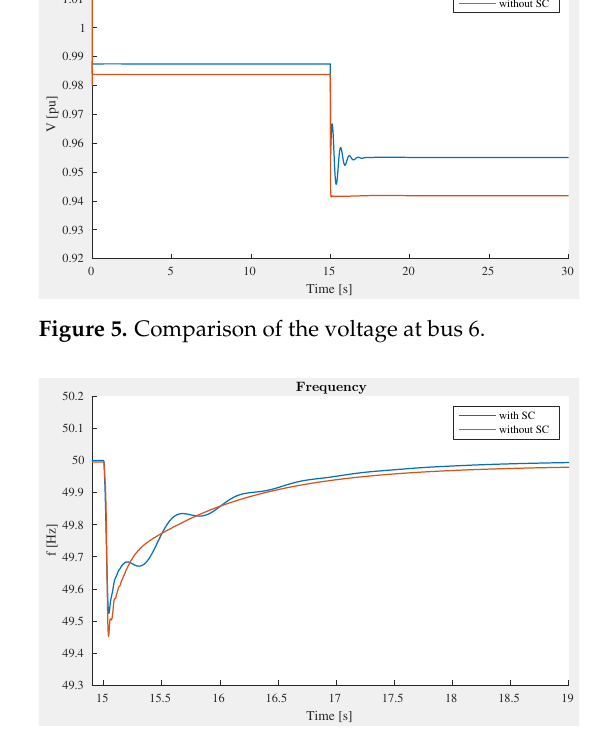
Figure 6. Comparison of the frequency at bus